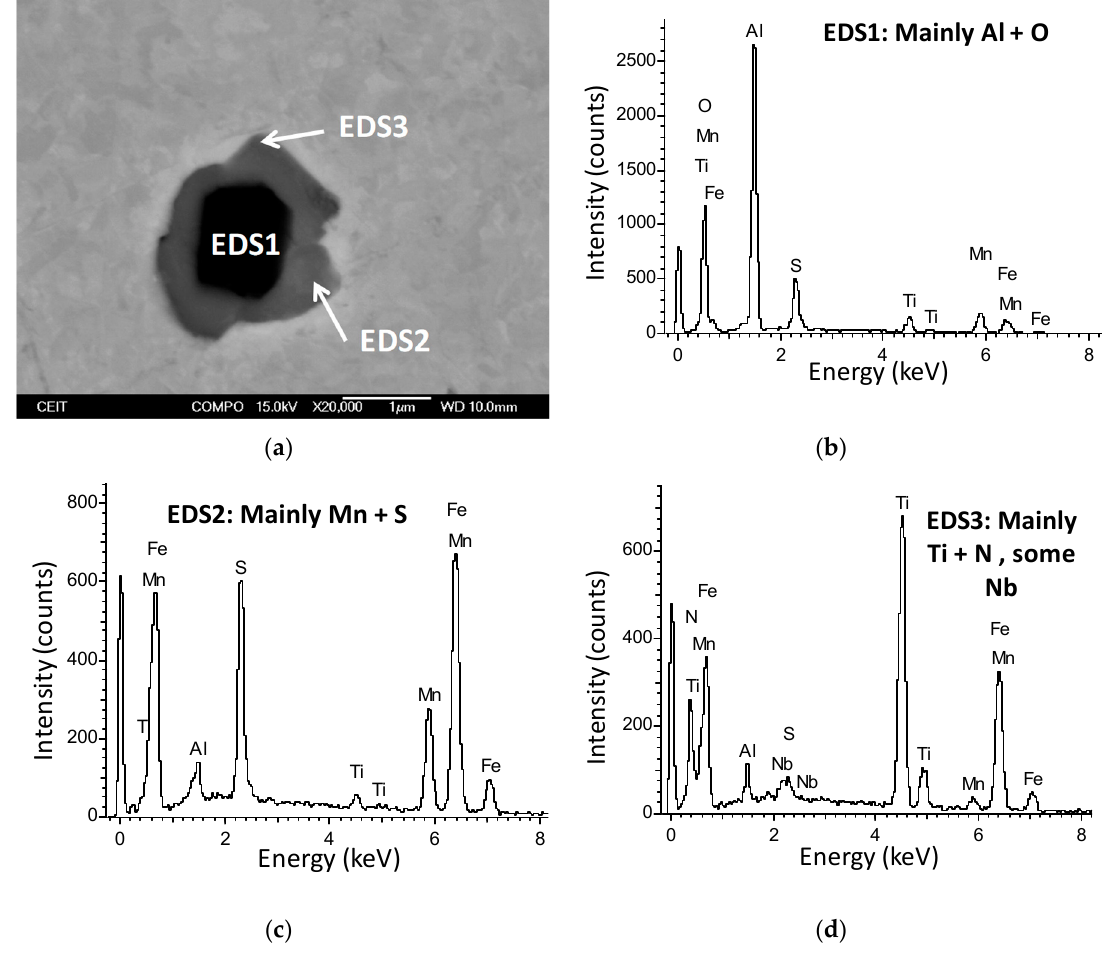
Figure 3. ( a ) Example of a Ti-complex precipitate observed by field-emission gun scanning electron microscopy (FEG-SEM) in the Ti5Nb3 sample quenched for initial microstructure analysis and ( b – d ), corresponding EDS analysis .